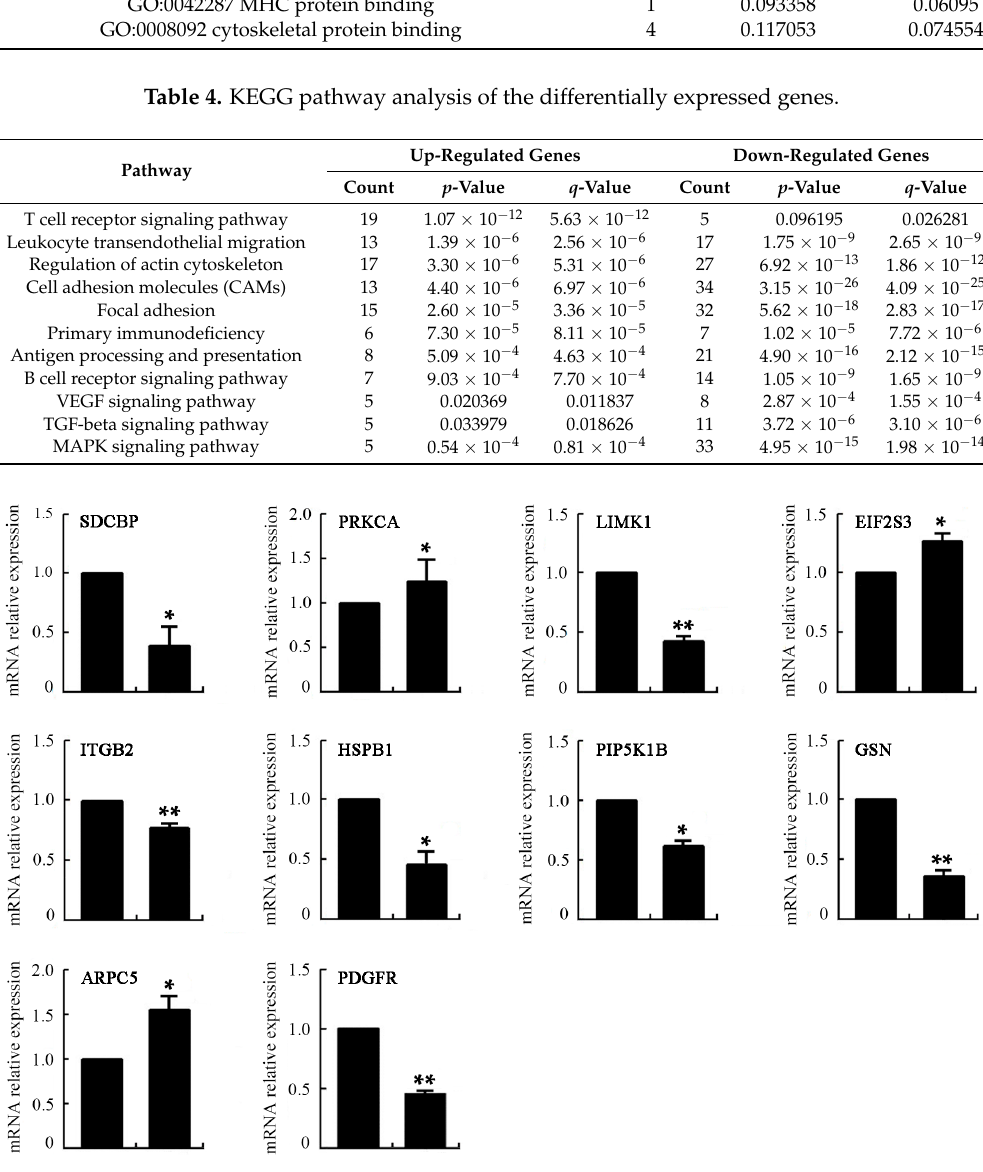
Figure 9. The mRNA expression levels of mDCs after treatment with 50 ng/mL VEGF determined by real-time PCR. Compared with control group, * p < 0.05, ** p < 0.01.